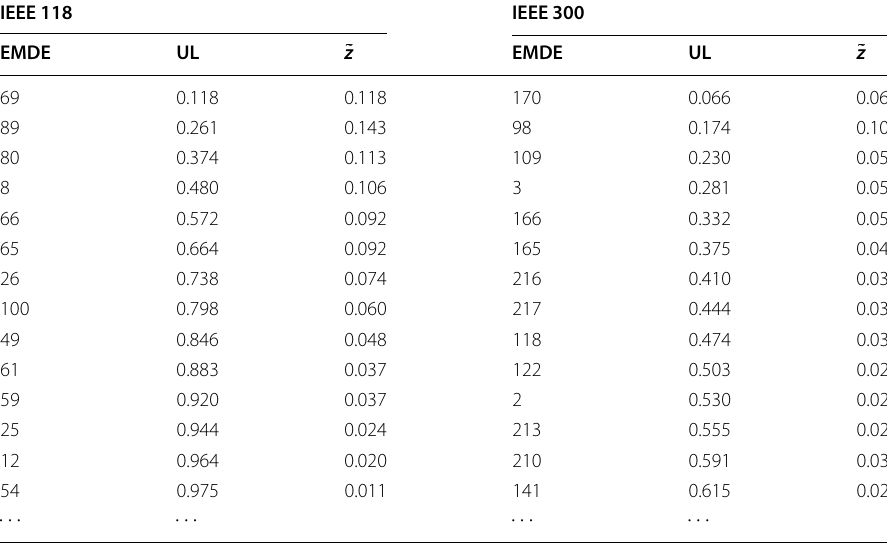
Table 2 Initial buses removed corresponding to the EMDE for IEEE 118-bus and IEEE 300-bus test